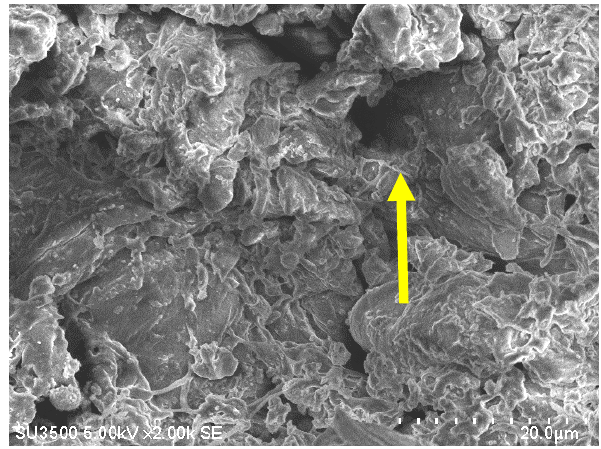
Figure 4. An example of an SEM image of sago fiber composite, taken from sample E9. The yellow arrow shows a void.